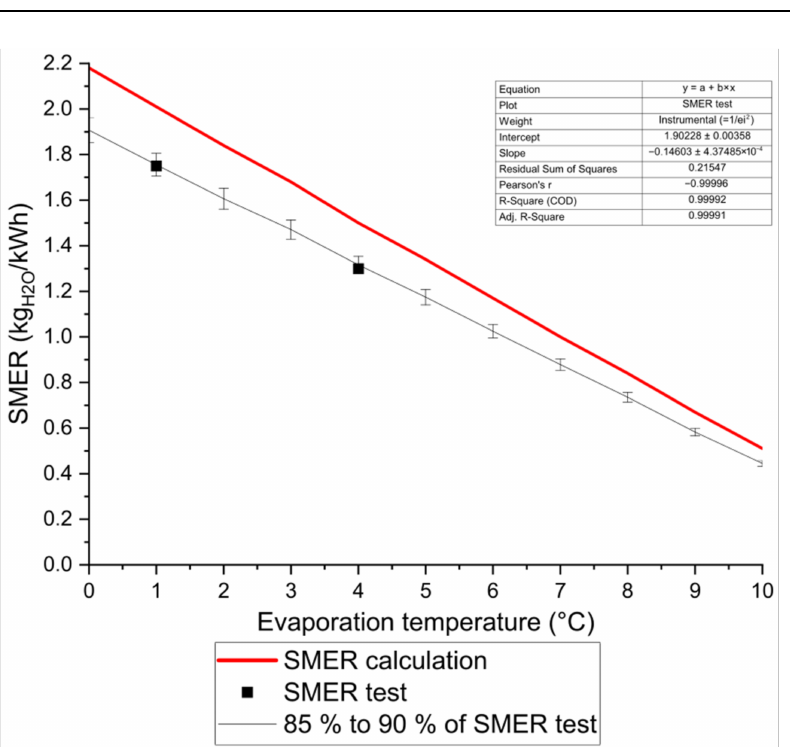
Figure 5. Diagrams of changes in the theoretical SMER index depending on the evaporation temperature. According to theoretical calculations with real efficiencies of elements, the equation of the black curve in Figure 5 is: